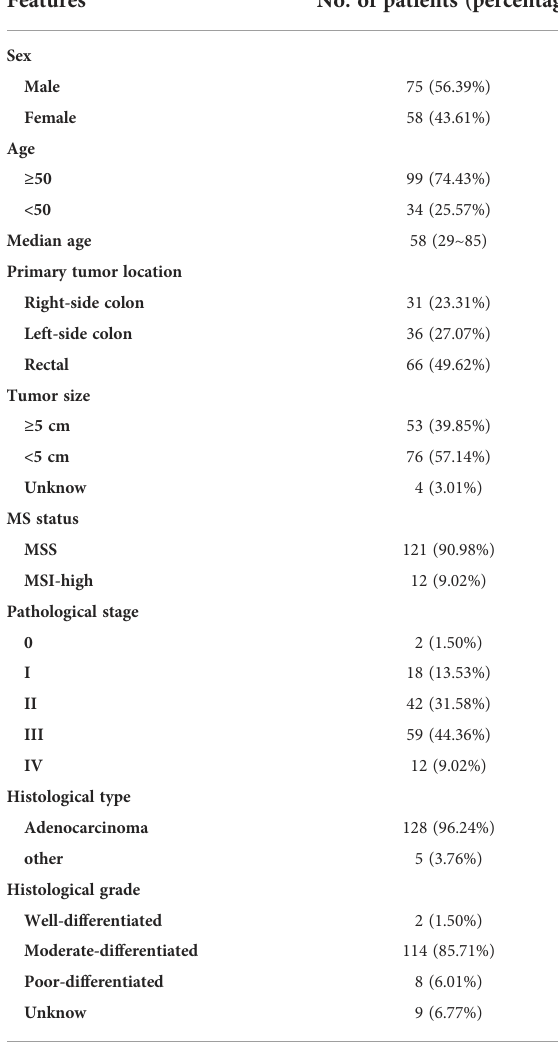
TABLE 1 The clinical features of enrolled